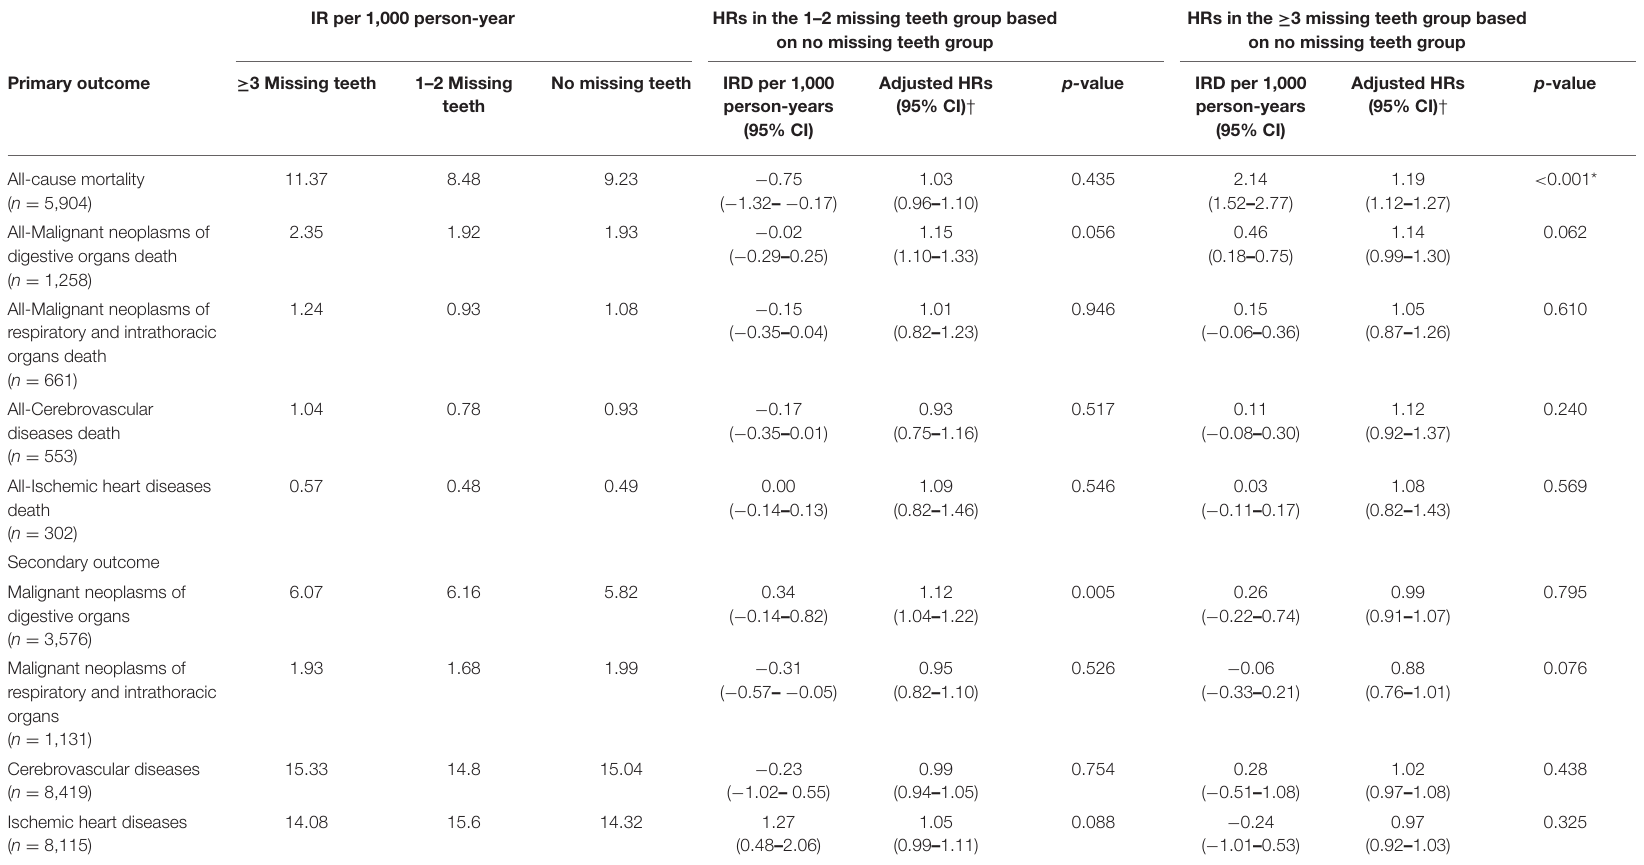
TABLE 2 | Association between the number of missing teeth, All-cause mortality, mortality of major diseases of death cause, and event of major diseases of death cause. IR per 1,000 person-year HRs in the 1–2 missing teeth group based HRs in the ≥ 3 missing teeth group based on no missing teeth group on no missing teeth